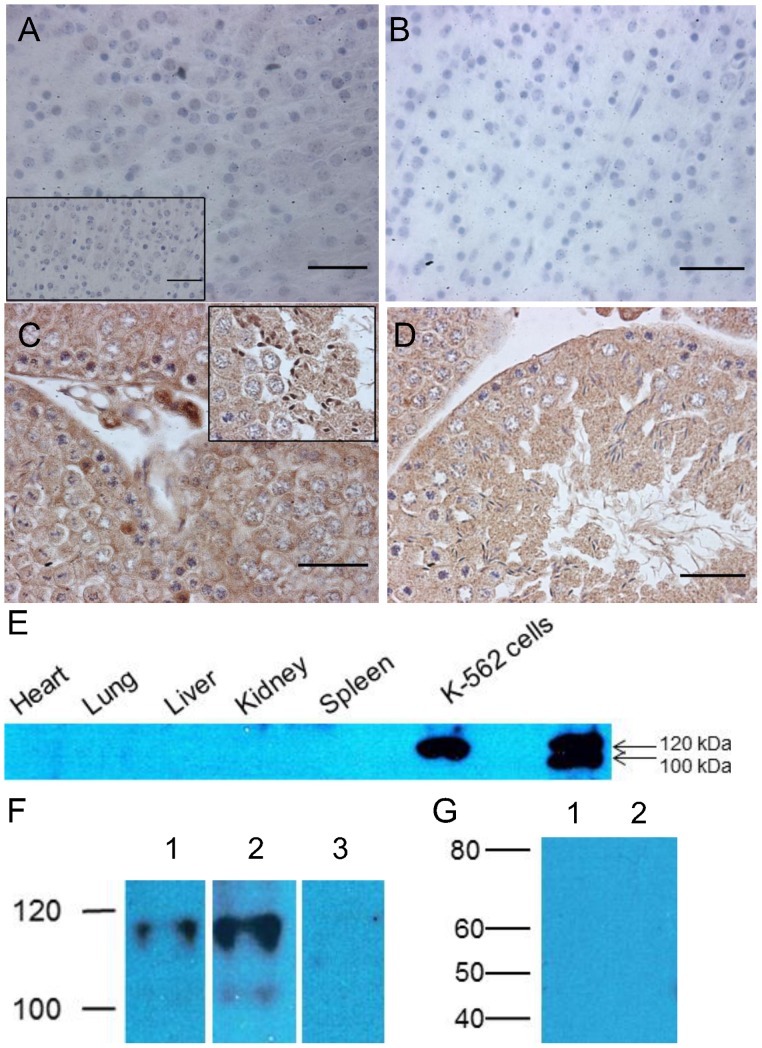
Hltf expression in null and control tissues.Panel A, immunostained coronal section from motor cortex of newborn control brain at 40X with a 20X (inset) shows pale staining, compared with the no antibody control at 40X in Panel B. Panel C, comparatively strong immunostaining in what appear to be secondary spermatocytes and leydig cells (40X) was well as spermatids (40X inset) in seminiferous tubules from newborn control mice. Panel D, Hltf immunostaining was absent from all stages of spermatogenesis in Hltf null seminiferous tubules (40X). Panel E, Western blot of immunoprecipitates shows the absence of Hltf protein from tissues from Hltf null mice compared with K-562 cells (robust, positive control for 115-kDa human Hltf). Panel F, Western blots of Hltf expression in brain extracts of wild-type control mice (lanes 1 and 2), and brain extracts of null mice (lane 3). Hltf from full-length Hltf mRNA isoform 1 is shown in lane 1. Prolonged exposure (10 minutes) of Western blots from control brain (lane 2) revealed faint evidence of a protein product from the truncated Hltf mRNA isoform 2. No Hltf is detected in the brains of Hltf null mice by Western blot regardless of the exposure time. Panel G, no truncated Hltf proteins are detected in the brains of Hltf null mice. Antibodies to HLTF - N-terminus (panels C, D and F), residues 164–300 (panel G1), and residues 600–700 (panels A, B, E and G2) – were used. The antibodies used in panel G1 would have identified truncated Hltf protein (44 kDa) from the original ATG, and antibodies used in panel G2 would have identified truncated Hltf proteins (45 kDa, 64 kDa) from the ATG introduced by the deletion of the NLS encoding sequences. Scale bar, 100 µm.